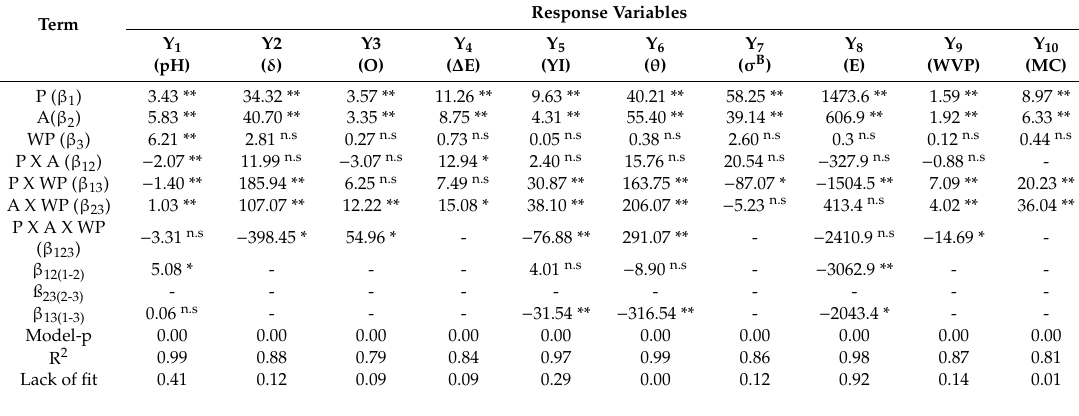
Table 2. Regression coe ffi cients of the response variables for pseudo-components and analysis of variance for fitted models.